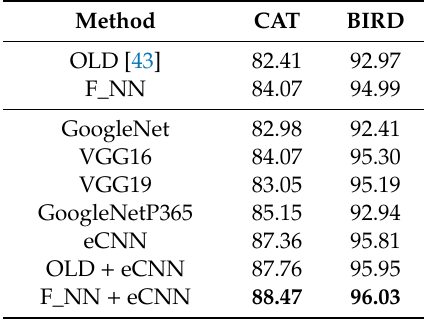
Table 6. Performance obtained considering di ff erent standard